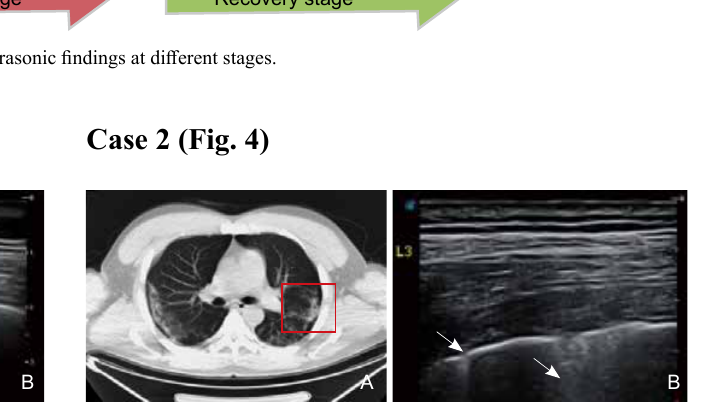
Figure 4 A 40-year-old male, early progressive stage, complained of chest tightness and breath shortness after activity 2 days prior to the admission. He had a 37.8℃ fever, without chills, cough, or sputum. The result of nucleic acid test was positive. Chest CT (A) showed multiple patch exudation shadows mainly in the peripheral area within bilateral lungs. The ultrasound (B) displayed broad B-line in the corresponding area with unsmooth pleura